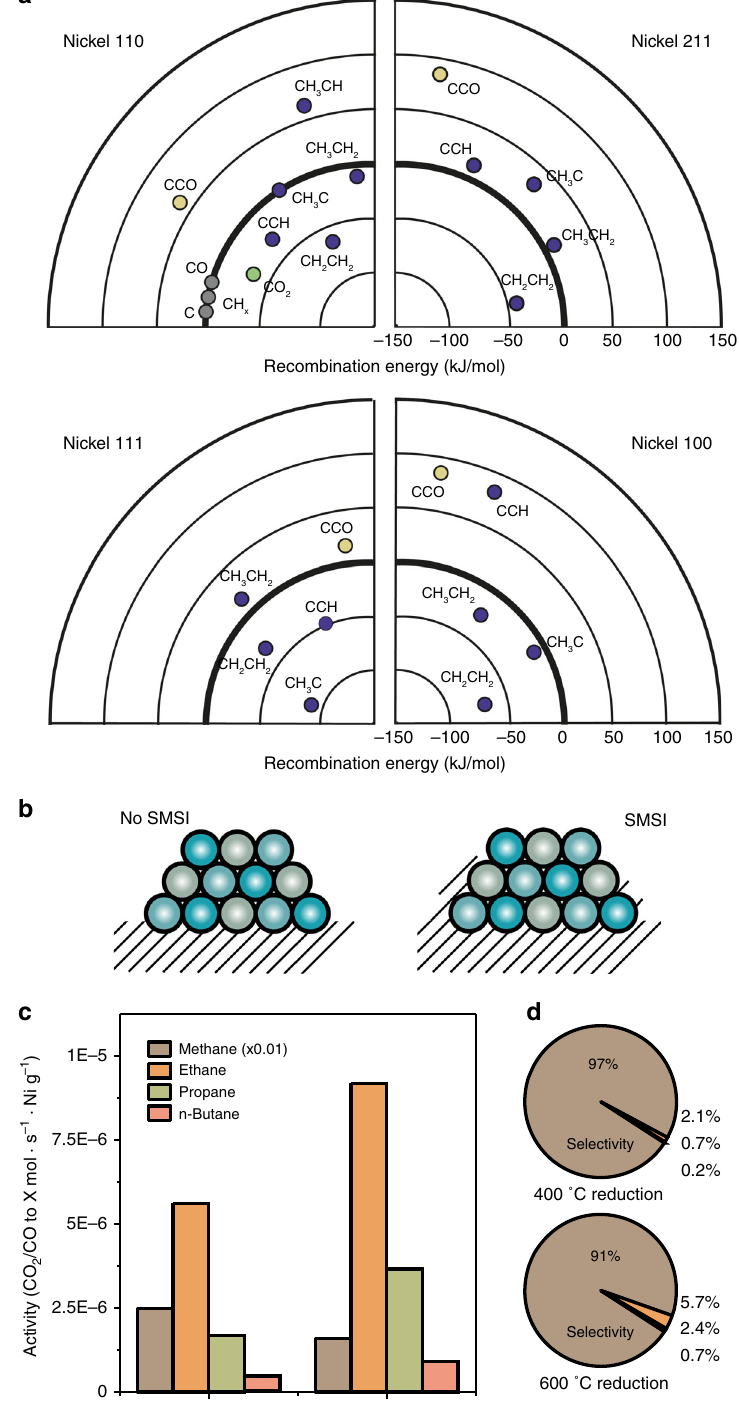
Fig. 4 Strong metal-support interaction (SMSI) induced C – C coupling in CO 2 /CO hydrogenation over Ni. a , b Recombination energies relevant for C – C coupling and CO insertion, on terrace Ni(111), Ni(100), and stepped Ni(110), Ni(211) crystal facet. b Schematic showing supposed SMSI effects on a nanoparticle. Sub-oxides are believed to creep up over nanoparticles, affecting their exposed surface area and electronic structure. c Activity, d selectivity of a 6 wt% Ni/TiO 2 catalyst reduced at 400 and 600°C in CO 2 /CO (3:1) hydrogenation at 300 °C at 4